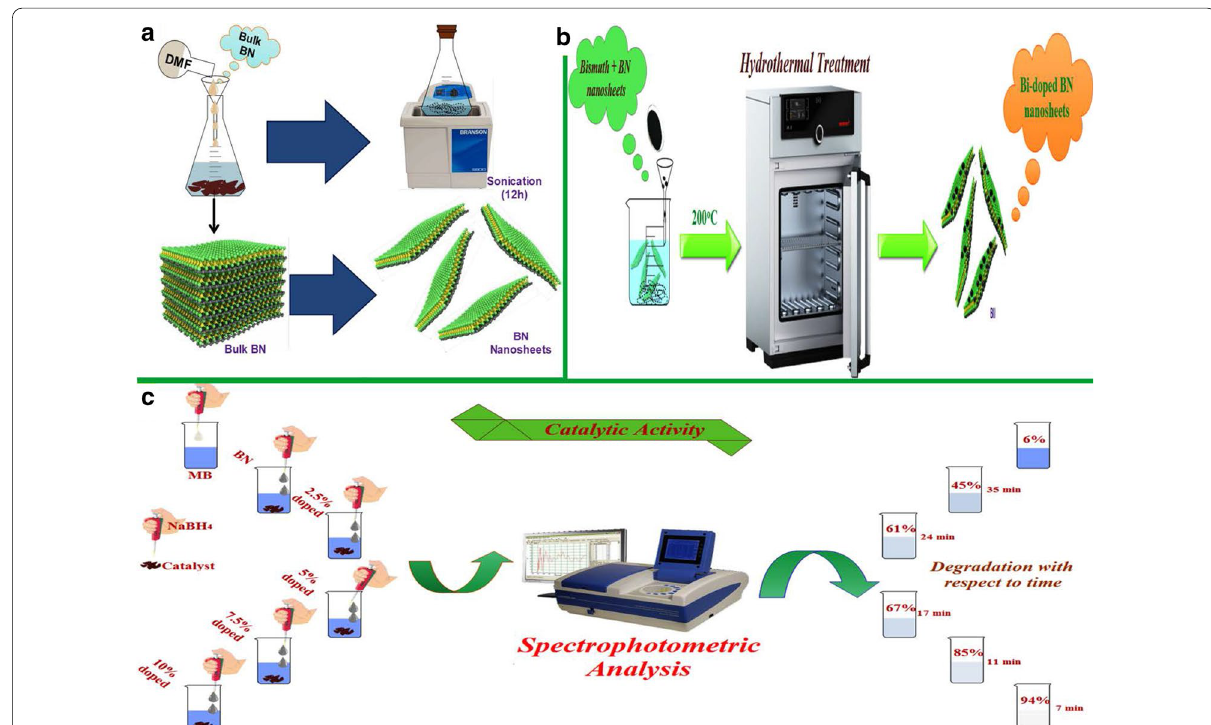
Fig. 1 Schematic representation of a liquid phase exfoliation of bulk BN; b hydrothermal synthesis; c catalytic